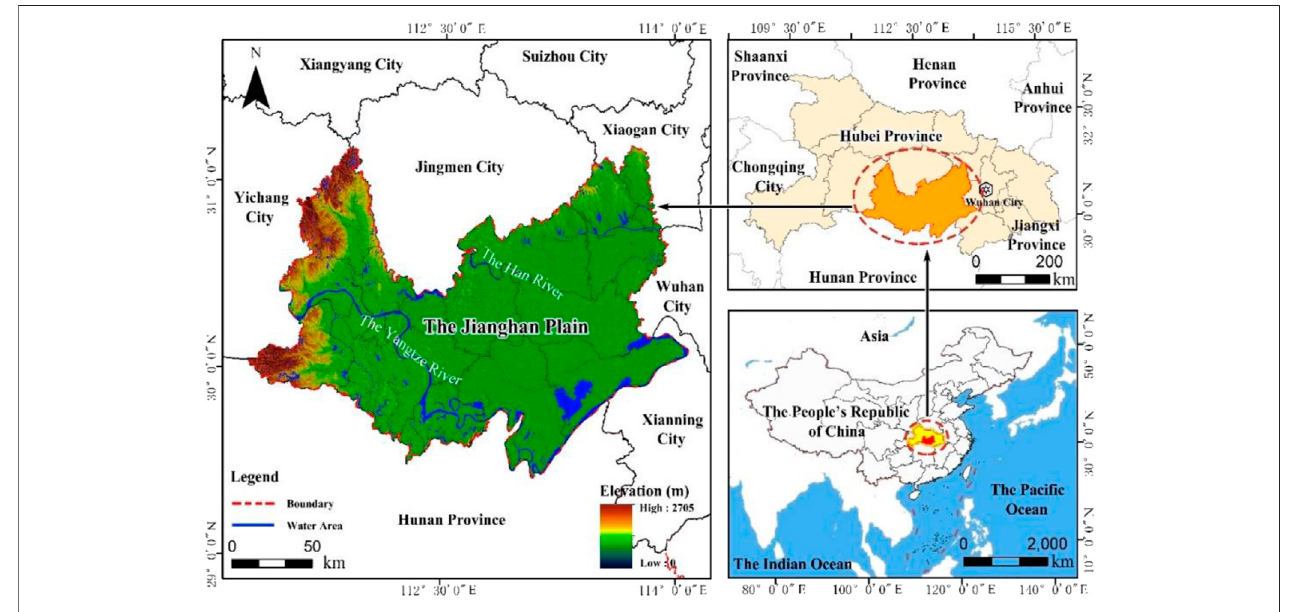
FIGURE 2 | Location of the study area.